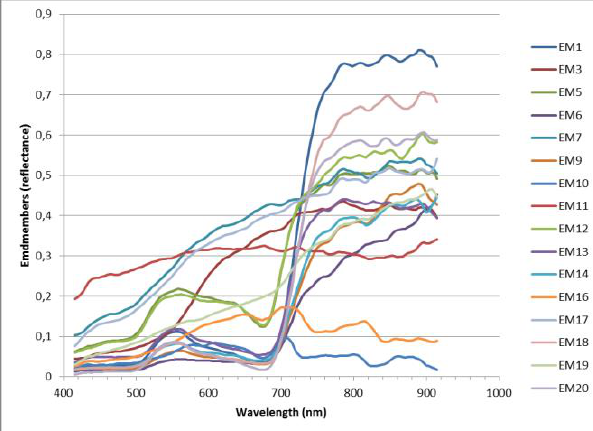
Figure 6: Endmembers obtained with OSP